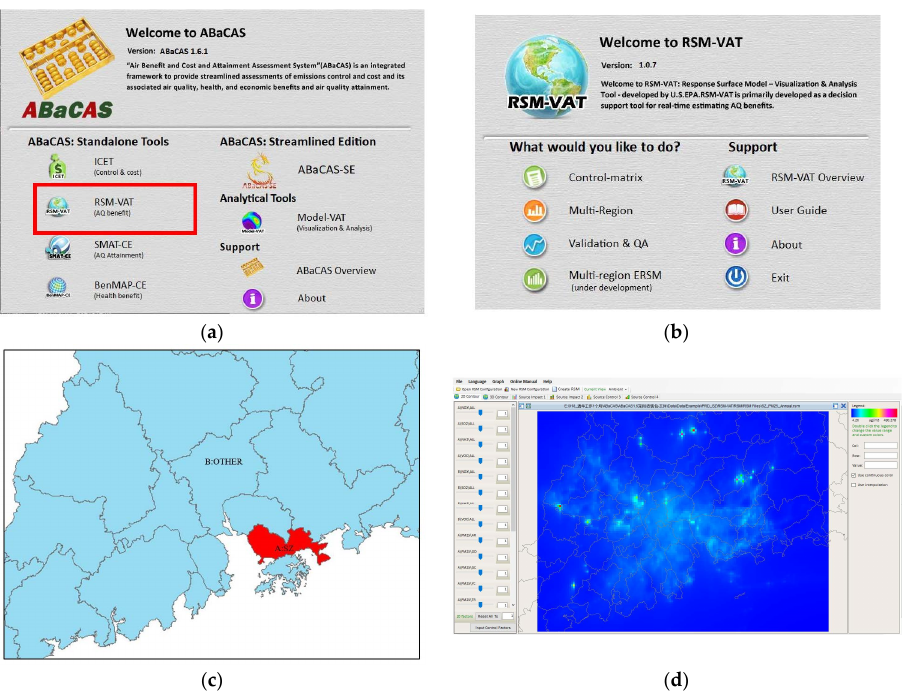
Figure 3. Key interface and parameters in the ABaCAS: ( a ) interface of the ABaCAS [68]; ( b ) interface Figure 3 of the RSM-VAT [69]; ( c ) geographical boundary of simulation [74]; ( d ) concentration distribution (default visualization of the annual average concentration of PM 2.5 in the base year) [74]. The RSM-VAT control panels operated in this study were the PM 2.5 -related control panel and the O 3 -related control panel. Both sets of control panels were divided between SZ and OTHER. The emission ratios of NO x , SO 2 , NH 3 , VOCs, and PM 2.5 are parameters